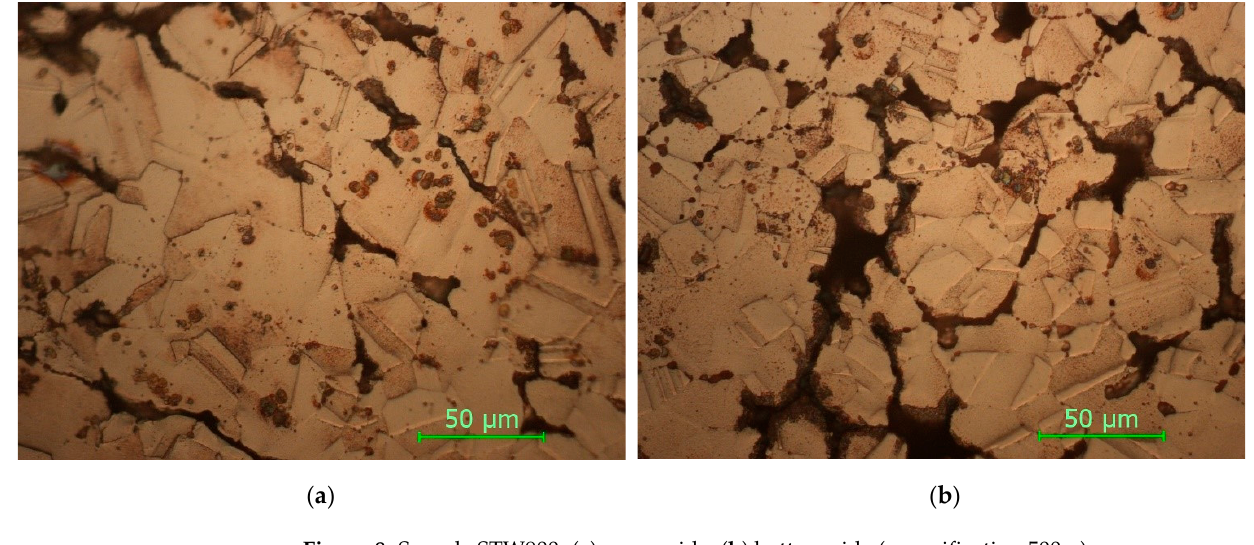
Figure 8. Sample STW900: ( a ) upper side; ( b ) bottom side (magnification 500×).